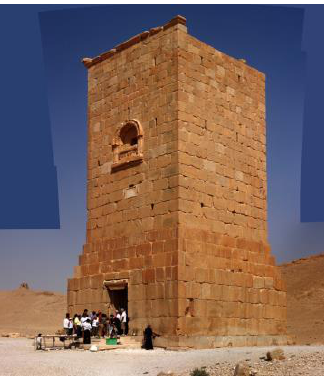
Figure 14 – Palmira a monumental tomb, one of the twelve panoramas sorrounding the monument